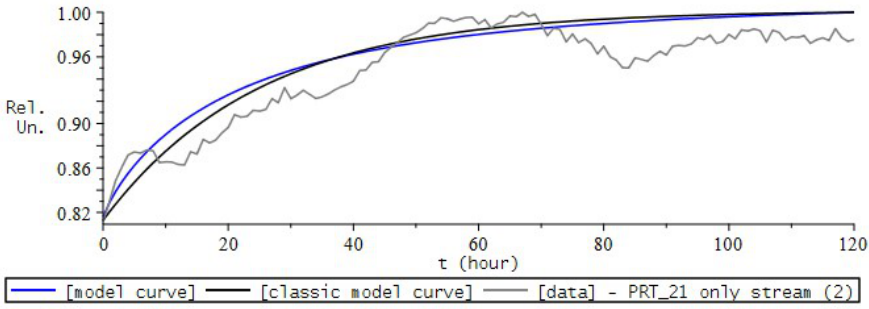
Figure 27. Correlation coefficients: 92.5% for the proposed (17) model (blue), and 93.7% for the classic (15) model